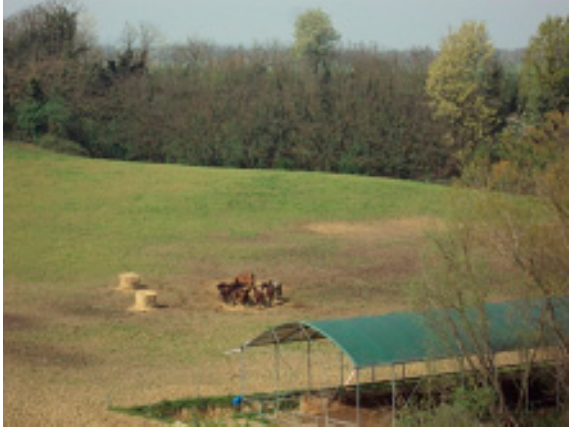
Figure 1. Paddock where the horses used for the experiment were kept daily and night.